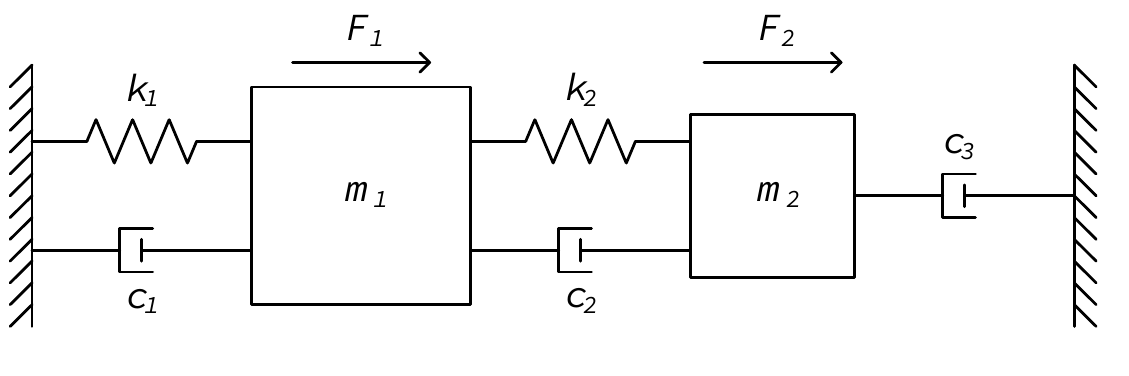
Figure 4. Double mass-spring-damper system model for the combined disk-comb